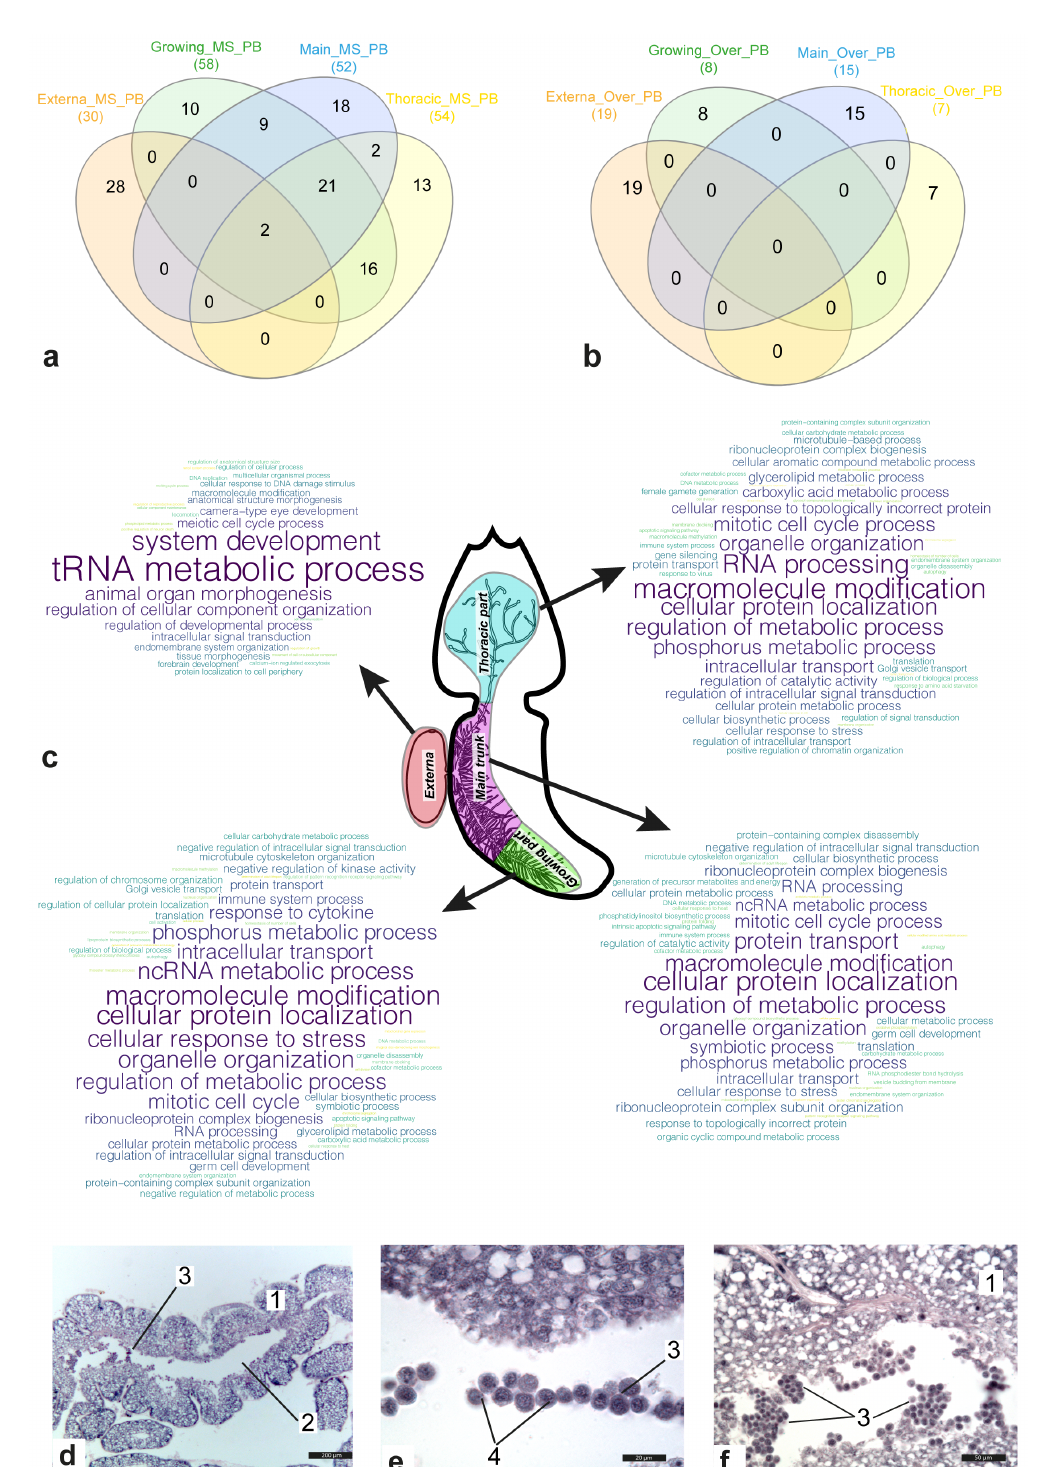
Figure 2. Gene set enrichment analysis (GSEA) results for the gene sets. ( a , b ) Venn diagram for sets of parental bioprocesses enriched with either genes included in the molecular signature of the body part ( a ) or genes over-expressed in body part considered ( b ). ( c ) Clouds of enriched parental bioprocesses for the body parts. Most often, the bioprocess was found in the list of enriched bioprocesses, the larger the word size. Abbreviations: MS/Over – bioprocesses enriched with genes included either in molecular signature or in sets of over-expressed genes; PB – parental bioprocesses. ( d – f ) Histological sections of the main trunk of P. reticulata 1 - the wall of the main trunk; 2 - central lumen; 3 - groups of the floating cells; 4 - Nuage body. Scale bars: d - 200µm, e - 20µm, f - 50µm.